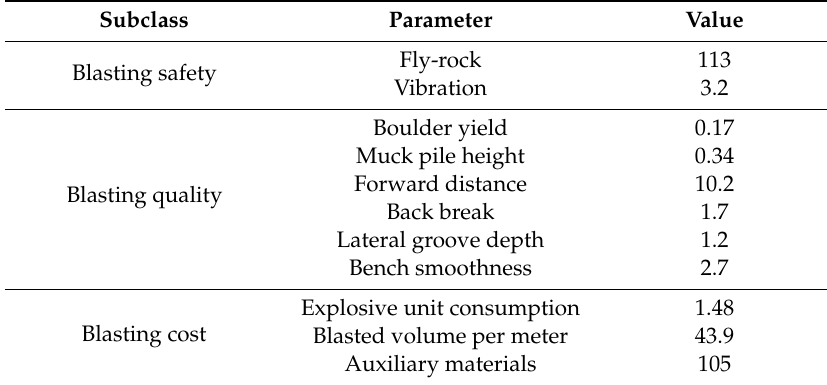
Table 6. Eleven parameter values of a typical blasting